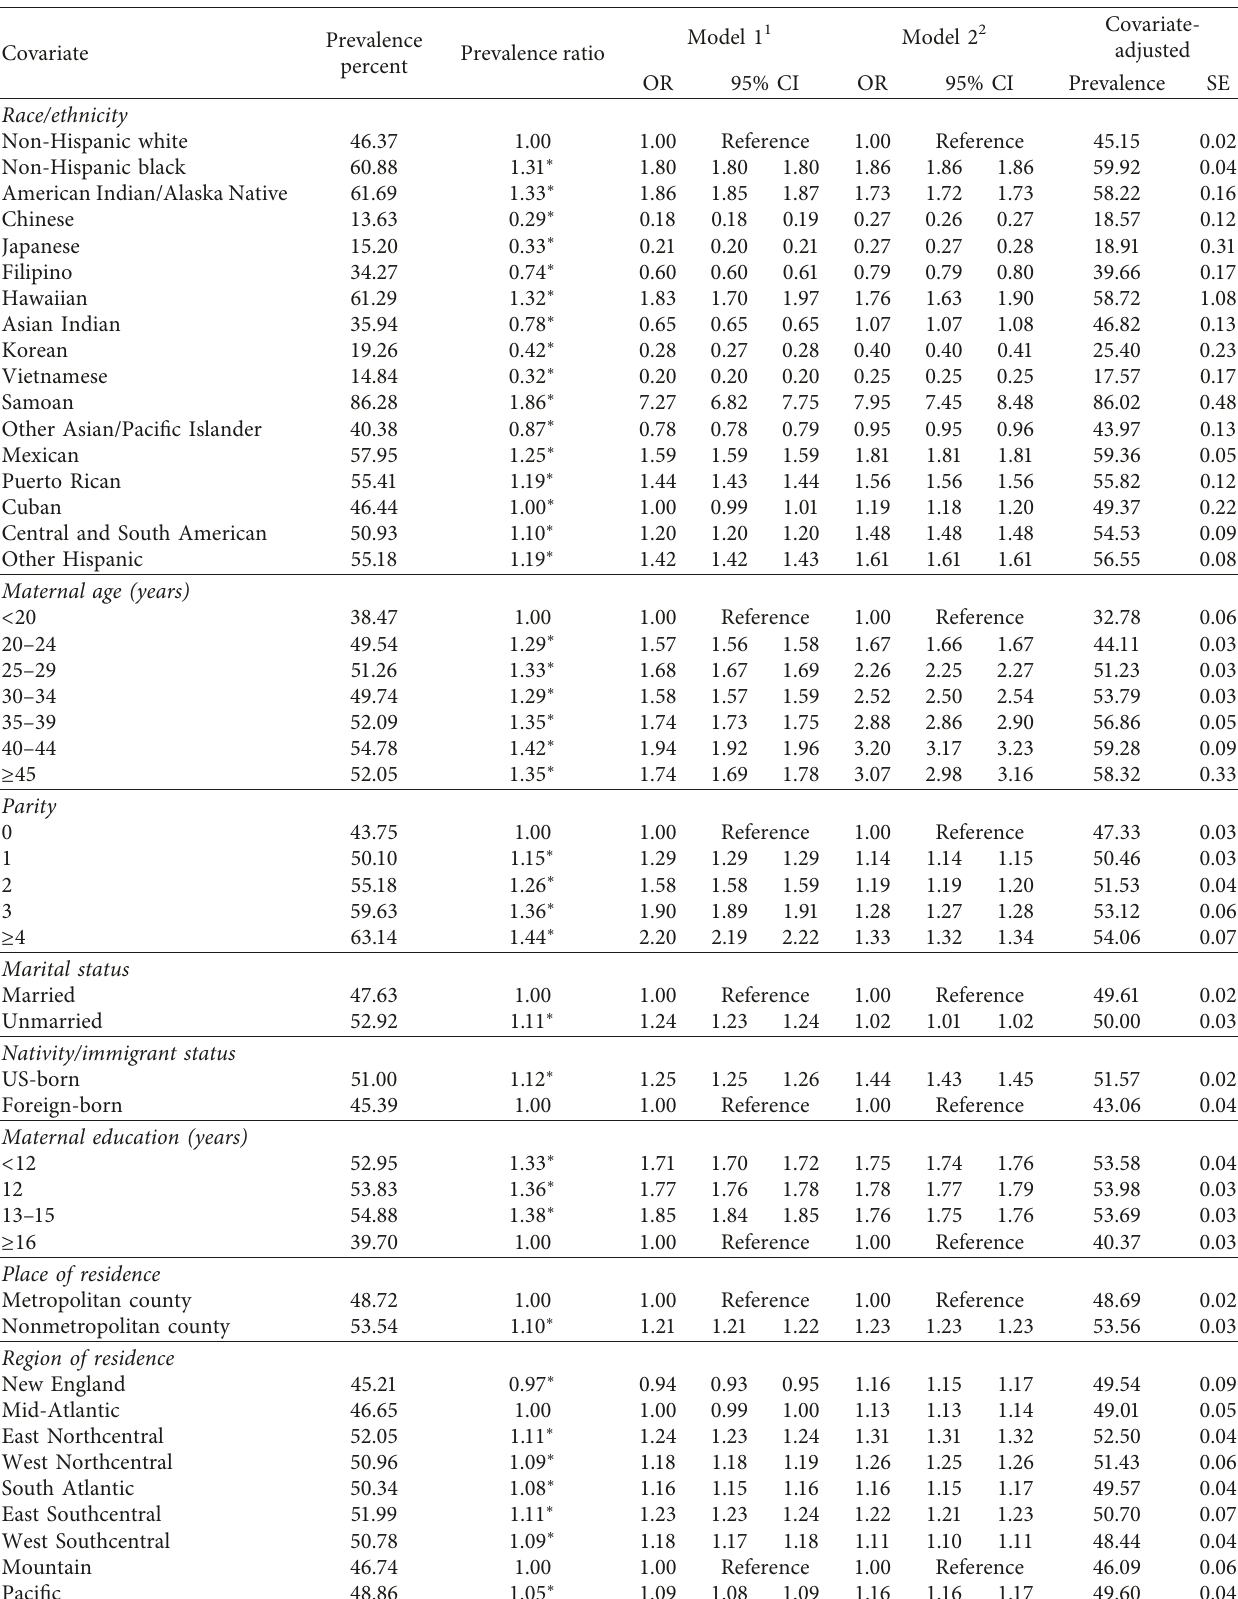
Table 2: Observed prevalence and logistic regressions showing unadjusted and covariate-adjusted differentials in pre-pregnancy overweight or obesity (BMI ≥ 25) among reproductive-age women in major racial/ethnic groups and by selected sociodemographic characteristics, United States, 2012–2014 ( N � 10 , 431 ,